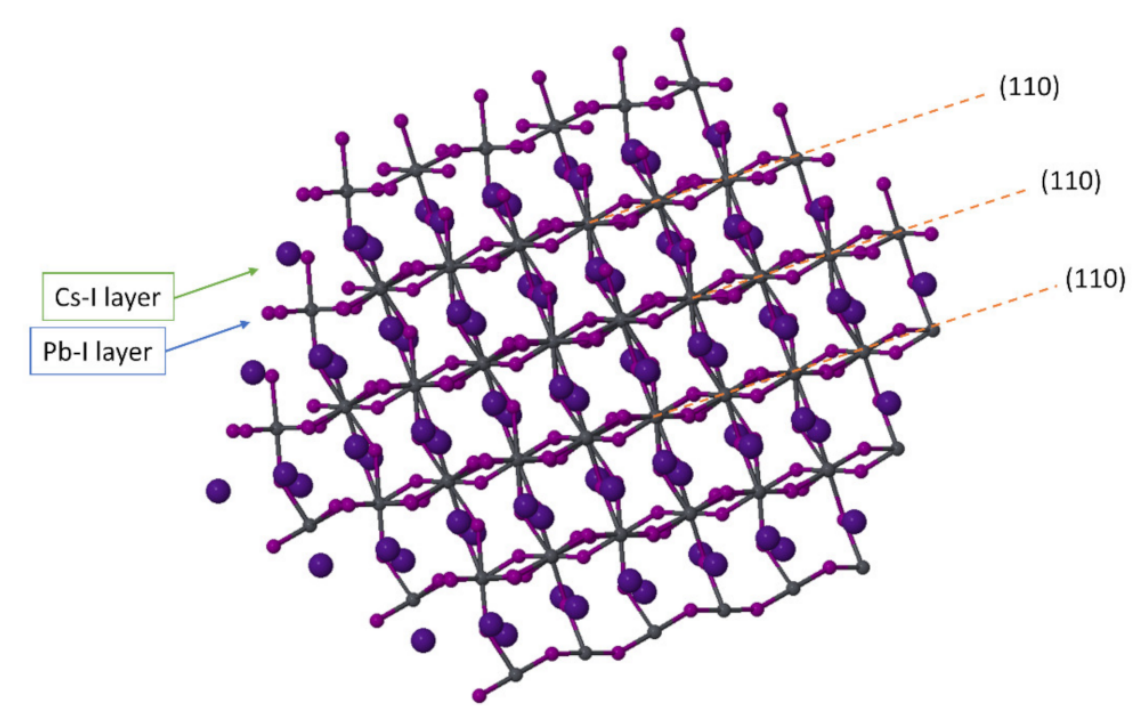
Figure 4. Scheme of a CsPbI 3 nanograin from the [1–11] zone axis showing the (110) crystallographic planes and the two different types of inorganic layers (Pb-I and